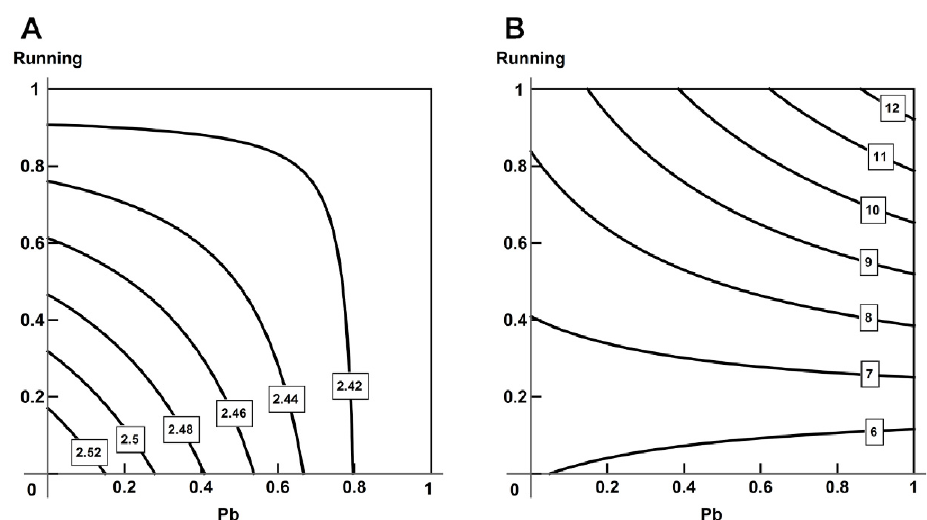
Figure 11. Variability of combined action of running and lead intoxication on ( A ) total Ca (from additive action towards subadditivity) and ( B ) VEGF (from single-factor action of exercise, through synergism, to additivity) in blood serum. Regression equations are y = 2.543 − 0.155 x 1 − 0.136 x 2 − 0.165 x 1 x 2 for ( A ) and y = 6.046 − 0.912 x 1 + 2.332 x 2 + 5.120 x 1 x 2 for ( B ).